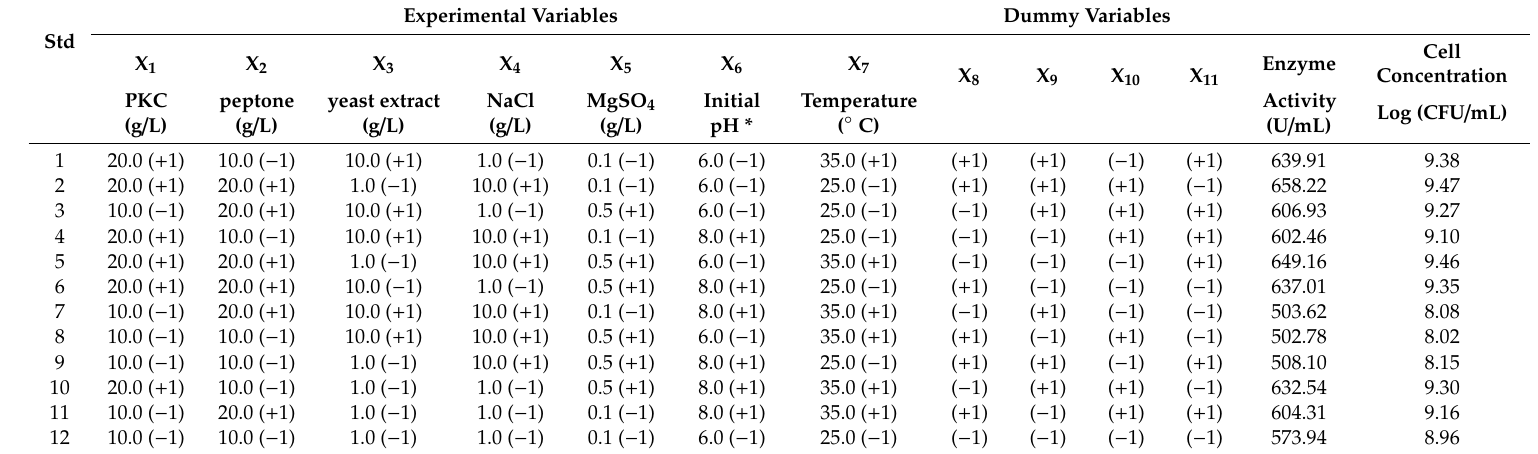
Table 2. Screening of influencing factor on β -mannanase production using